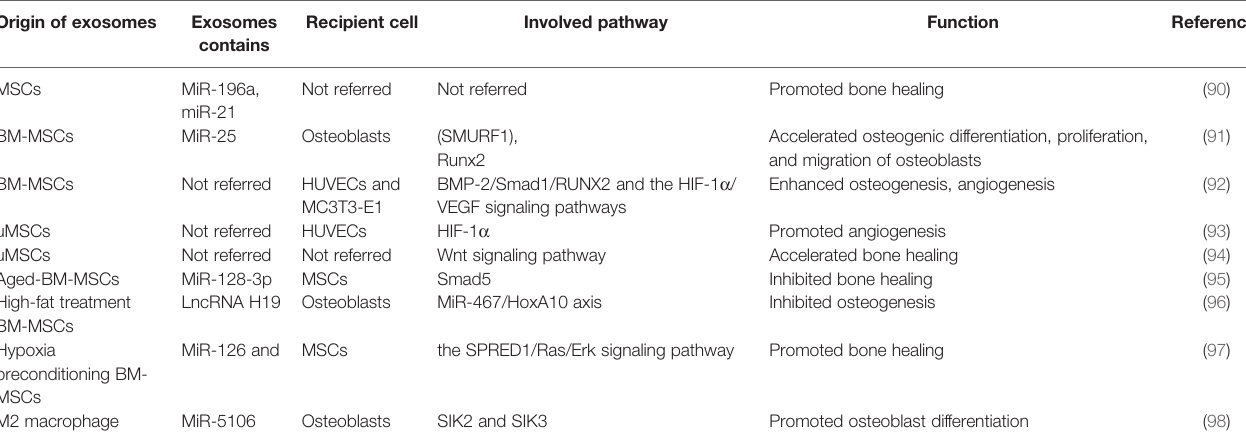
TABLE 3 | Exosomes in fracture